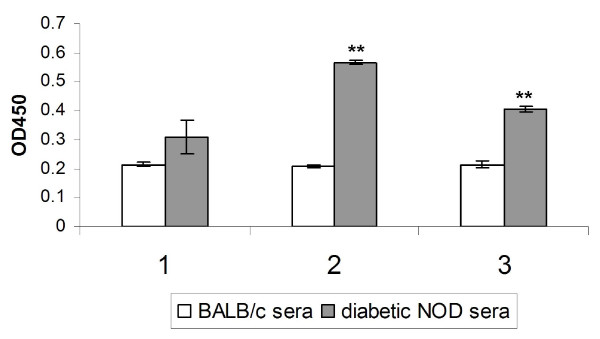
Demonstration of immunoreactivity with NOD mouse diabetic sera to algal-derived hGAD65. Purified algal-derived hGAD65 was coated onto 96-well plates and incubated with serum samples from diabetic NOD mice (n = 3) and reference BALB/c mice (n = 3). Bound anti-GAD antibody was detected with HRP-conjugated anti-mouse IgG. Error bars represent the standard deviation. ** above bars indicates a significant difference from reference BALB/c sera (p < 0.05).